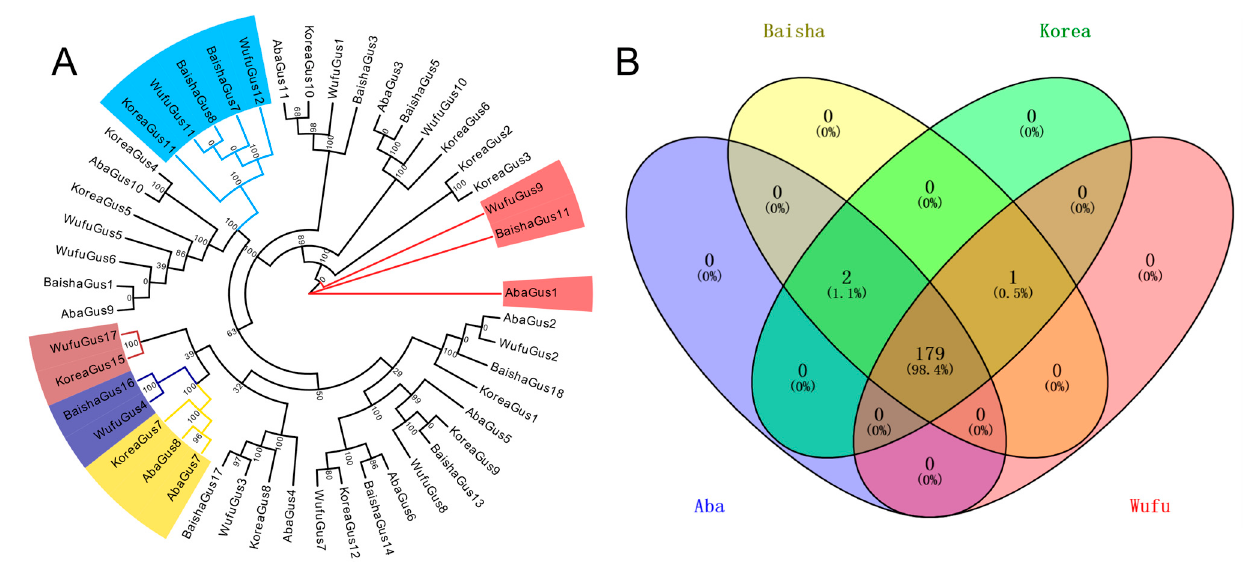
Figure 4. ( A ) Phylogenetic tree constructed by gustatory receptors from different A. cerana strains. Blue regions indicate only Aba lost; brown regions represent both Aba and Baisha lost; dark-blue regions indicate both Aba and Korea lost; yellow regions represent both Wufu and Baisha lost; red regions indicate only Korea lost. ( B ) The immune-related KEGG orthologs were identified in different A. cerana strains.